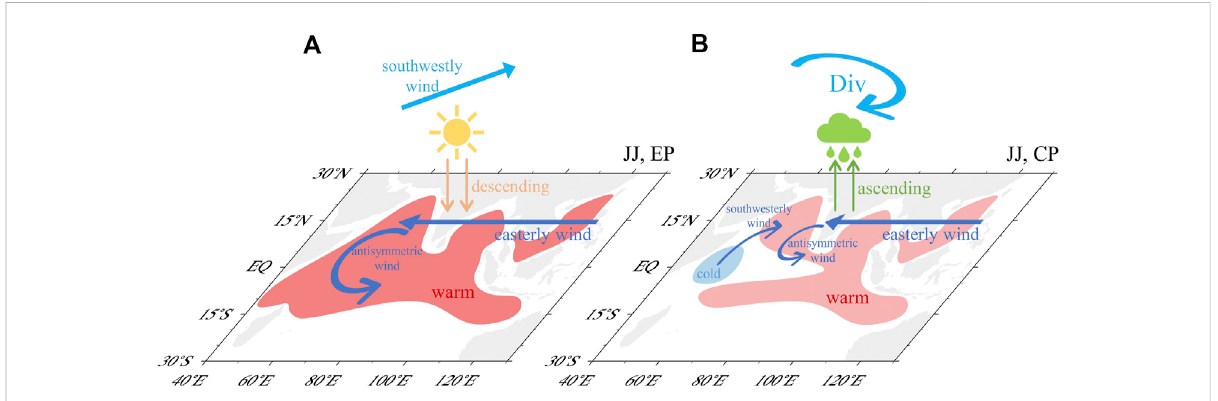
FIGURE 9 Schematicdiagram illustrating the mechanism of the responses of the sea surface temperature anomaly in thenorthern Indian Ocean to (A) EP and (B) CP El Niño events and their effects on Indian summer monsoon rainfall in early summer (June – July) in decaying